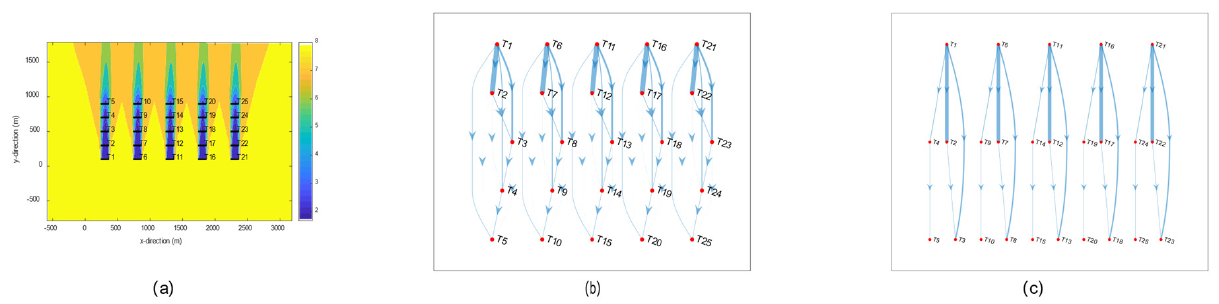
Figure 5. The wake digraph (𝜀 = 0.157481474) with wind direction 𝜑 = 90 °: ( a ) wake field; ( b ) original wake digraph ( 𝑘 = 0.1); ( c ) pruned wake digraph ( 𝑘 = 3.2 ).